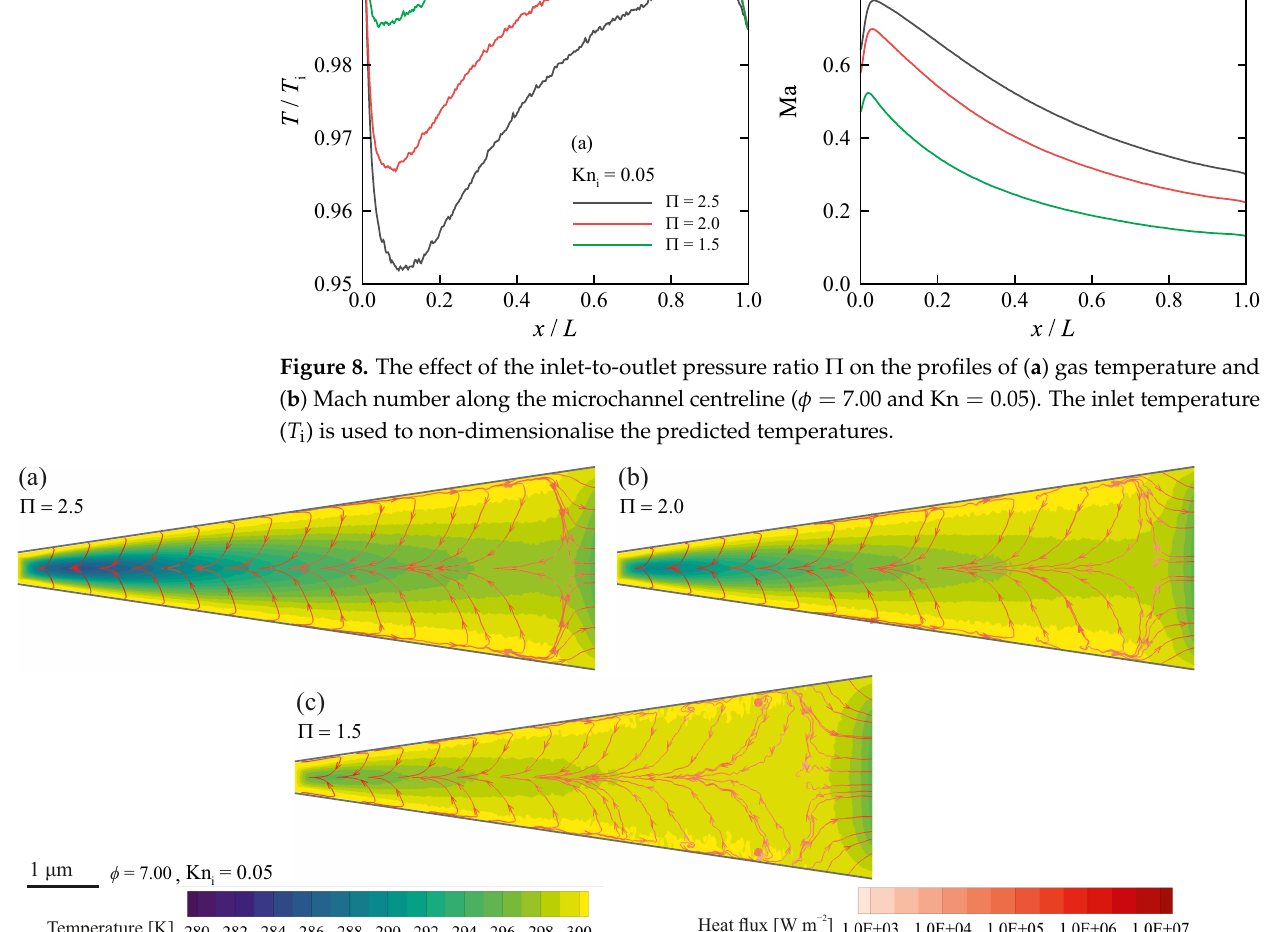
Figure 9. The influence of the inlet-to-outlet pressure ratio Π on the thermal field (contours) and heat flow direction (coloured by the magnitude of heat flux). Kn i = 0.05 and φ =